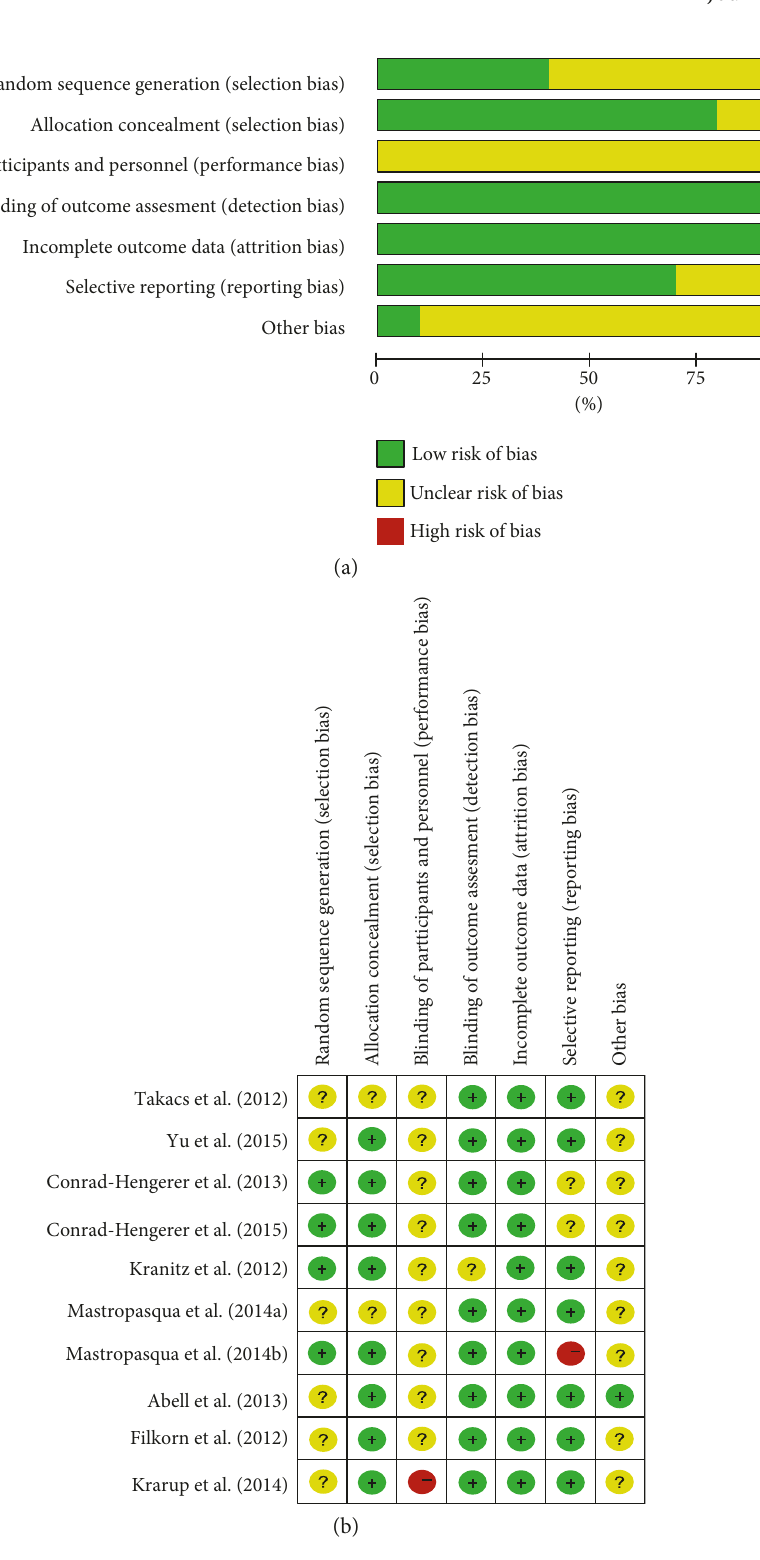
Figure 2: Risk of bias evaluation. (a) Risk of bias graph. (b) Risk of bias